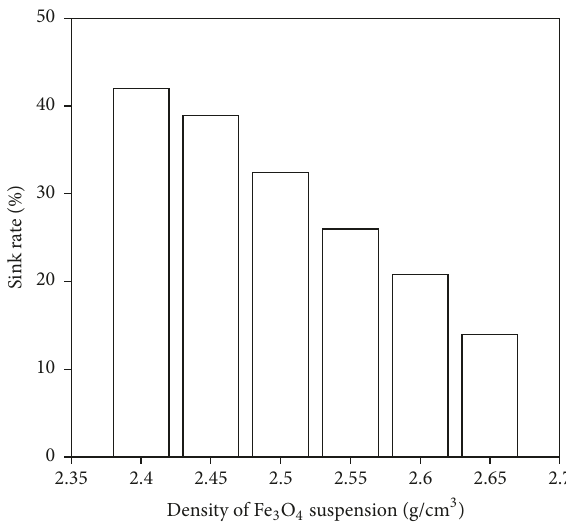
Figure 12: Variation of sink rate with changing the density of the Fe 3 O 4 suspension from 2.4 to 2.65 g/cm 3